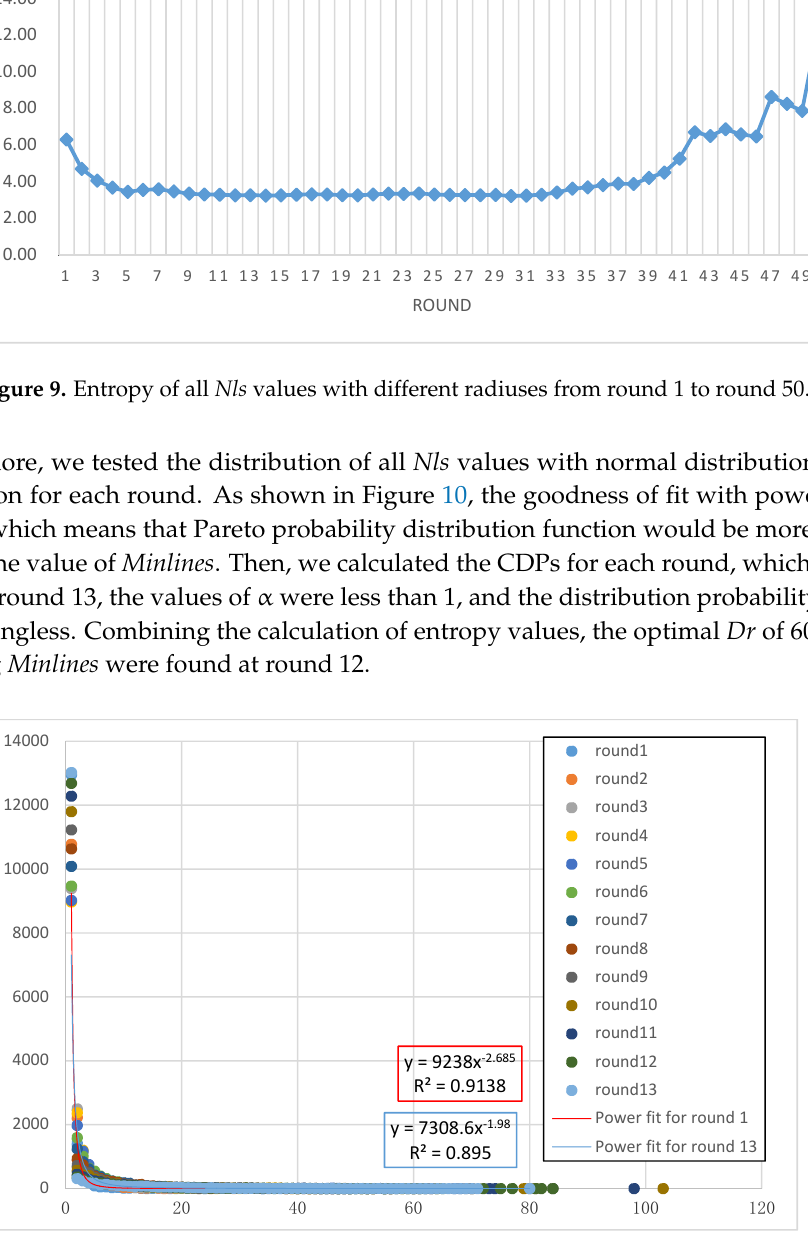
Figure 10. Distribution of all Nls values with different radius and the power law fitting lines.